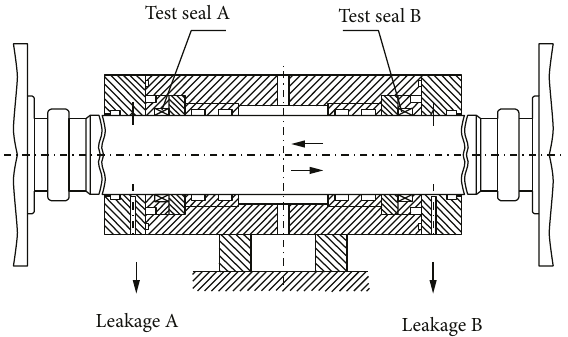
Figure 1: The sketch map of the reciprocating seal test.